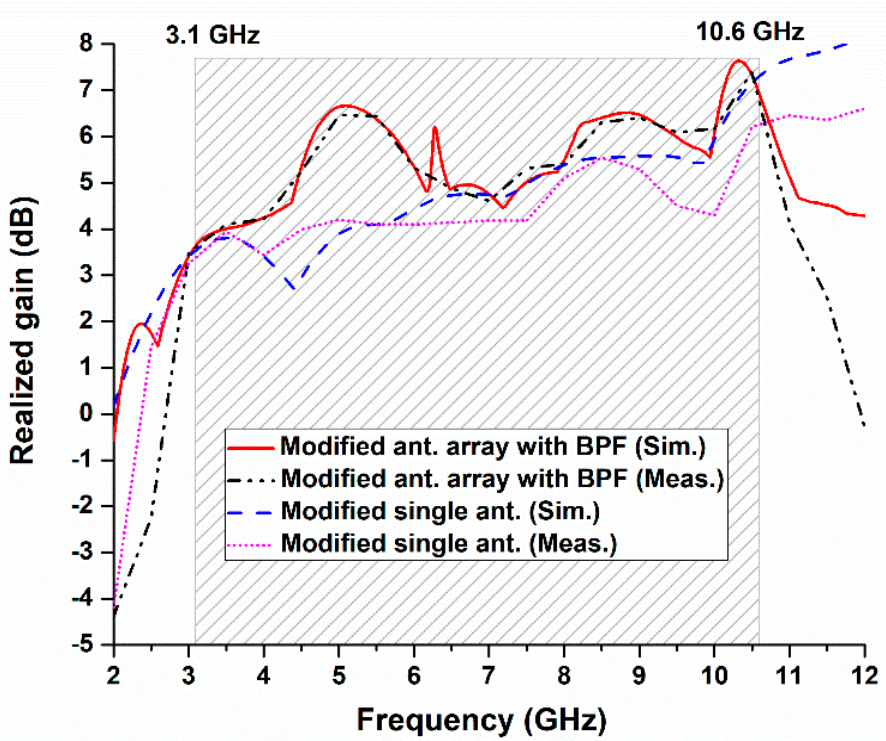
Figure 17. Simulated and measured realized gain of single modified UWB antenna and UWB filtering antenna array.